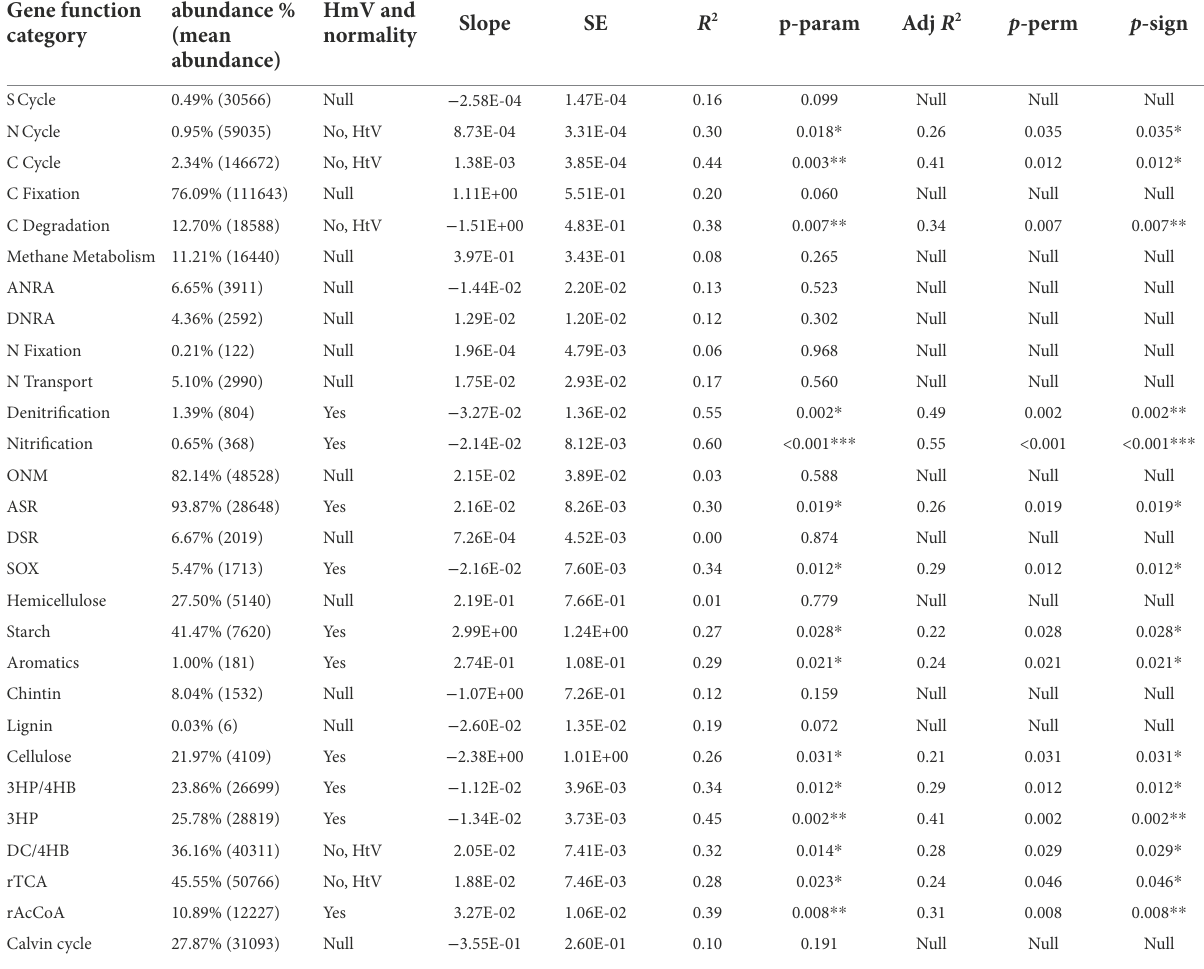
TABLE 2 Variations of the relative abundance of genes related to microbial biogeochemical cycling over different weathering times (mean relative abundance >1%).